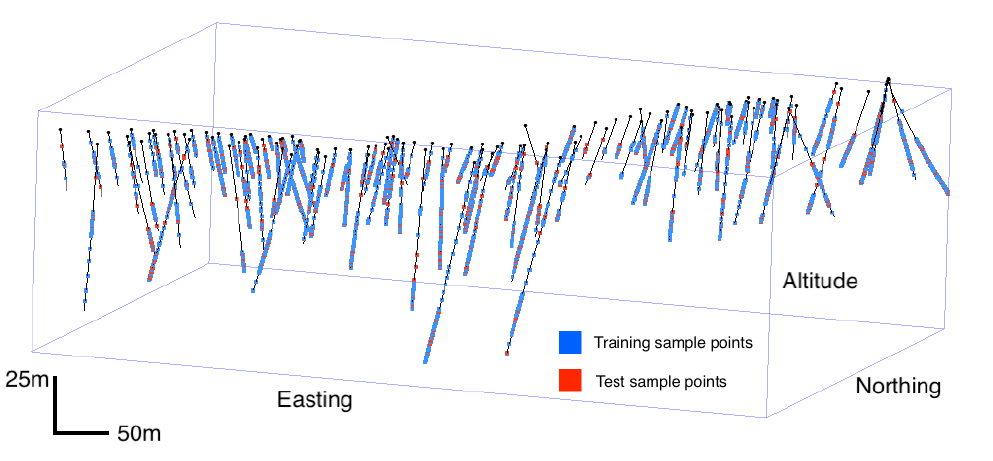
Figure 1. Location of train and test sample